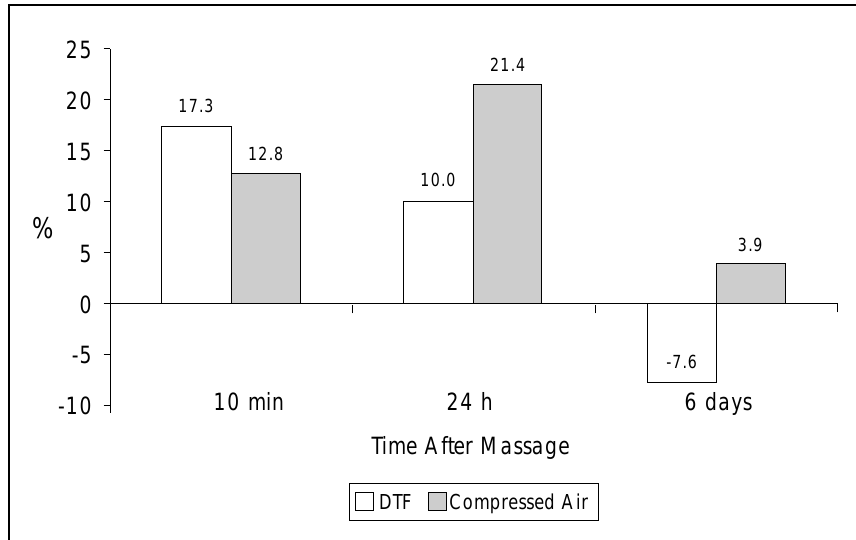
Figure 3: Percentage change in the cross-sectional area of capillaries after DTF or compressed air